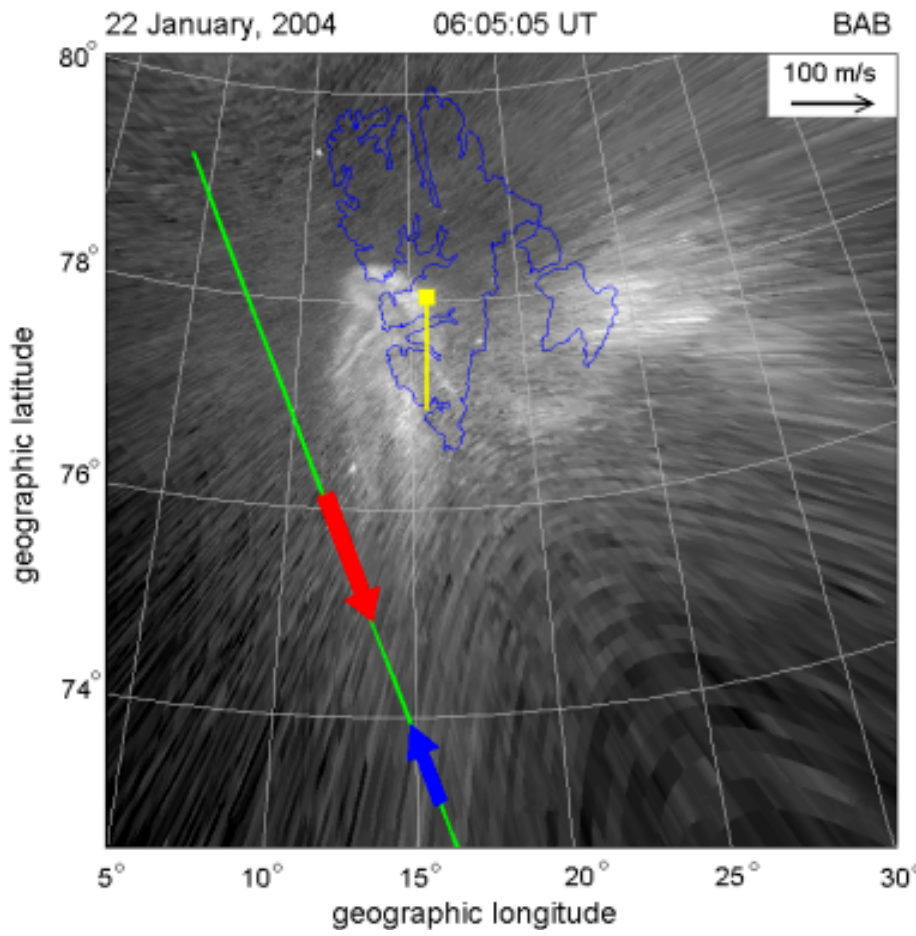
Fig.9. Location of the EISCAT UHF beam ( green line ) and EISCAT Svalbard field aligned Fig. 9. Location of the EISCAT UHF beam (green line) and EISCAT Svalbard field aligned beam (yellow line) with respect to the auroral torch. The colored arrows are the line-of-sight velocities measured at 09:05 UT (see Fig. 10). The yellow square corresponds to the beam ( yellow line ) with respect to the auroral torch. The colored arrows are the line-of- measurement point at altitude 115km. sight velocities measured at 09:05 UT (see Fig.10). The yellow square corresponds to the measurement point at altitude 115 km.